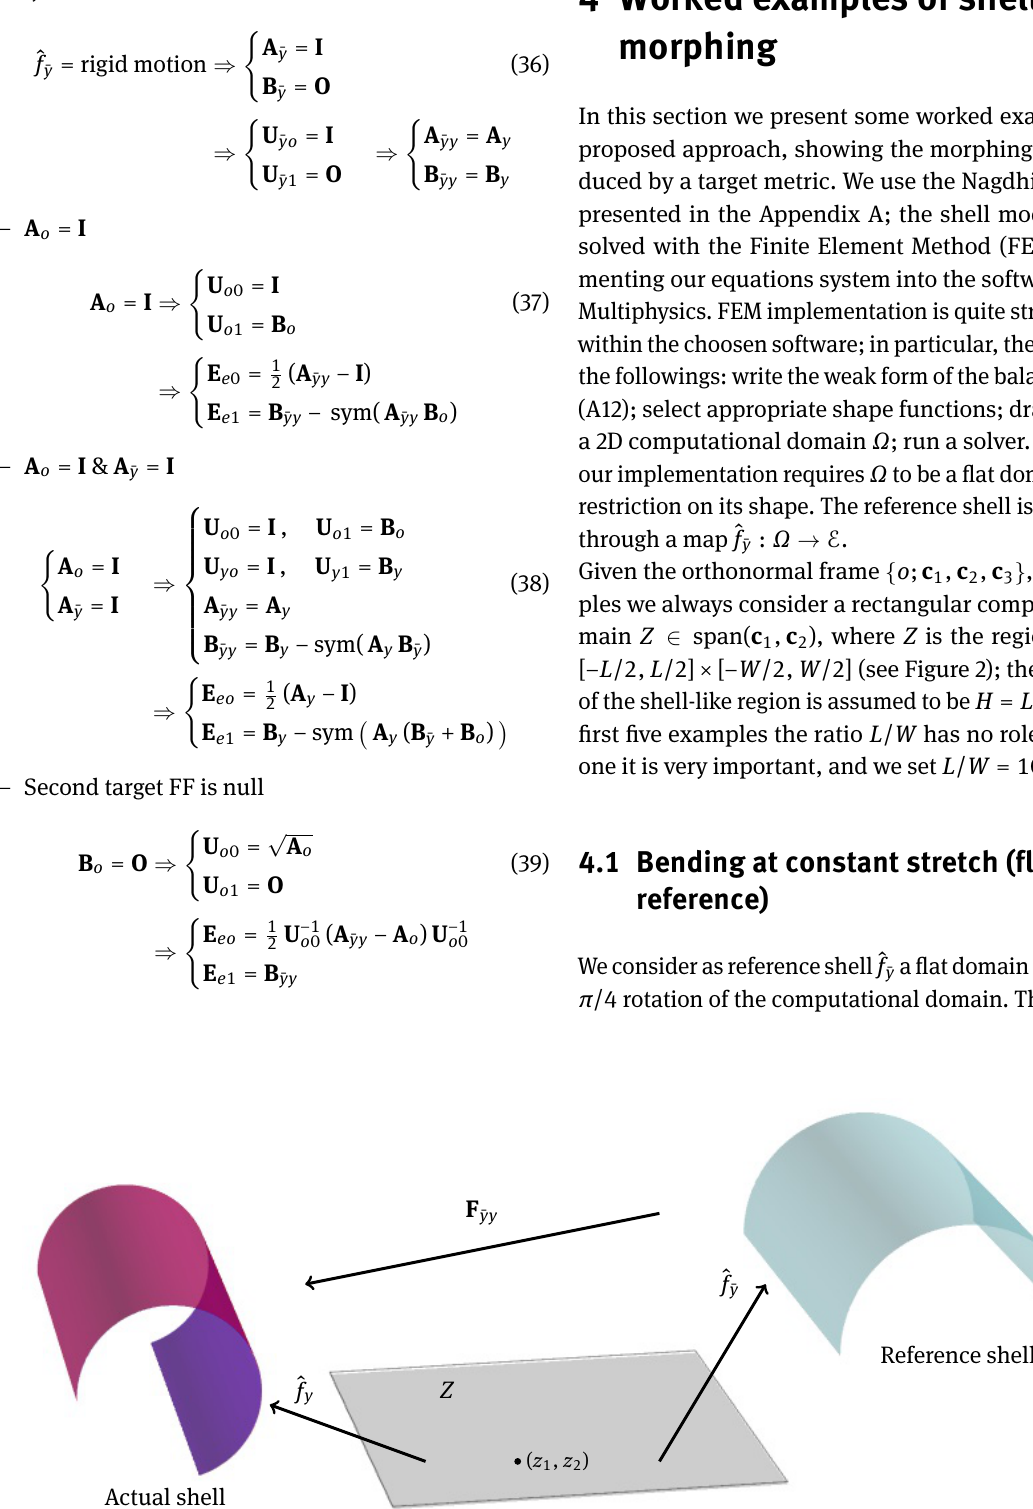
is found by assigning a target metric. The map F ¯ y